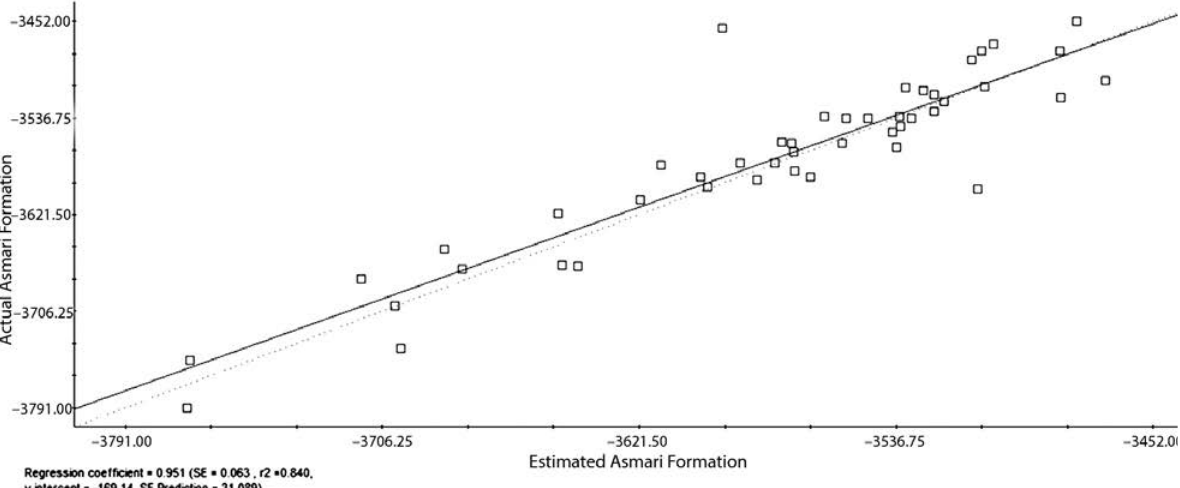
Fig. 6. Cross Validation Diagram for determining Error Estimation